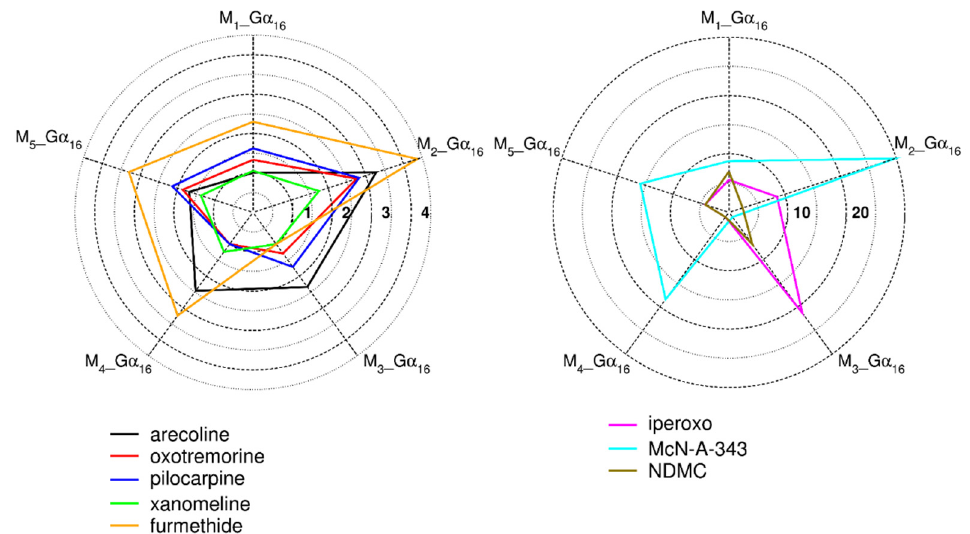
Figure 3. Polar plot of relative intrinsic activity RA i . Intrinsic activities of individual agonists relative to reference agonist carbachol (RAi) calculated according to Equation (8) from the measurement of the accumulation of inositol phosphates are plotted. Values are expressed as ratios of RAi to RAi at receptor with the lowest activity for given agonist (Arecoline M1; Furmethide, McN-A-343, Xanomeline M 3 ; NDMC, Oxotremorine, Iperoxo, Pilocarpine M 4 ).